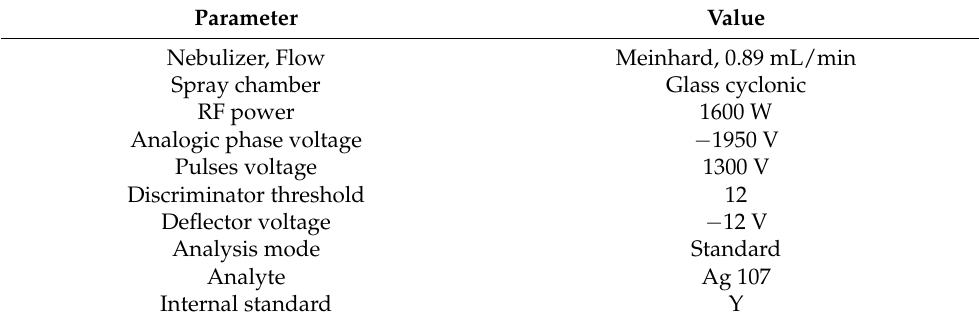
Table 2. NexION ® 350D ICP-MS instrumental condition for Total Ag in standard mode. Parameter Value Nebulizer, Flow Meinhard, 0.89 mL/min Spray chamber Glass cyclonic RF power 1600 W Analogic phase voltage − 1950 V Pulses voltage 1300 V Discriminator threshold 12 Deflector voltage − 12 V Analysis mode Standard Analyte Ag 107 Internal standard